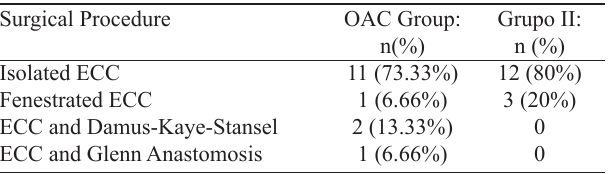
Table 2. Surgical procedure performed on total cavopulmonary